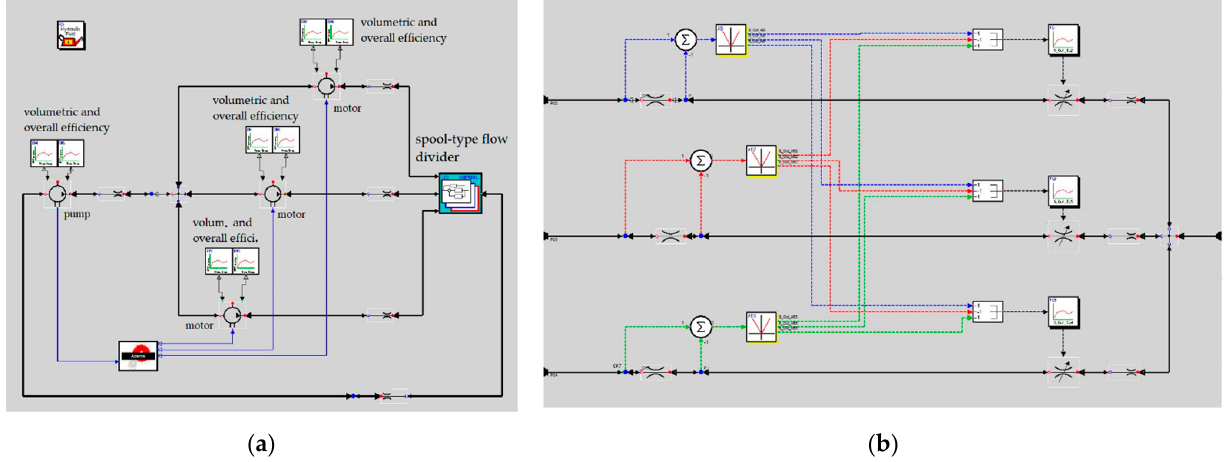
Figure 10. Model of the hydrostatic drivetrain with a spool-type flow divider ( a ) and the model of spool divider ( b ). The main hydrostatic drivetrain model parameters are presented in Table 3. Table 3. Values of main hydrostatic drivetrain model parameters.